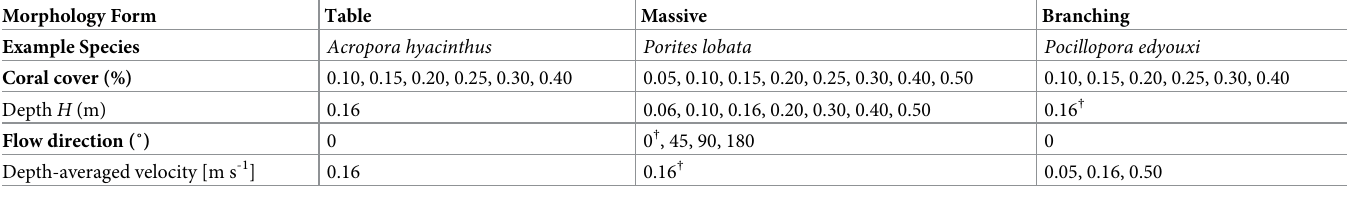
Table 1. The range of parameter values considered in the numerical simulations for each archetype coral colony morphology. Morphology Form Table Massive Branching Example